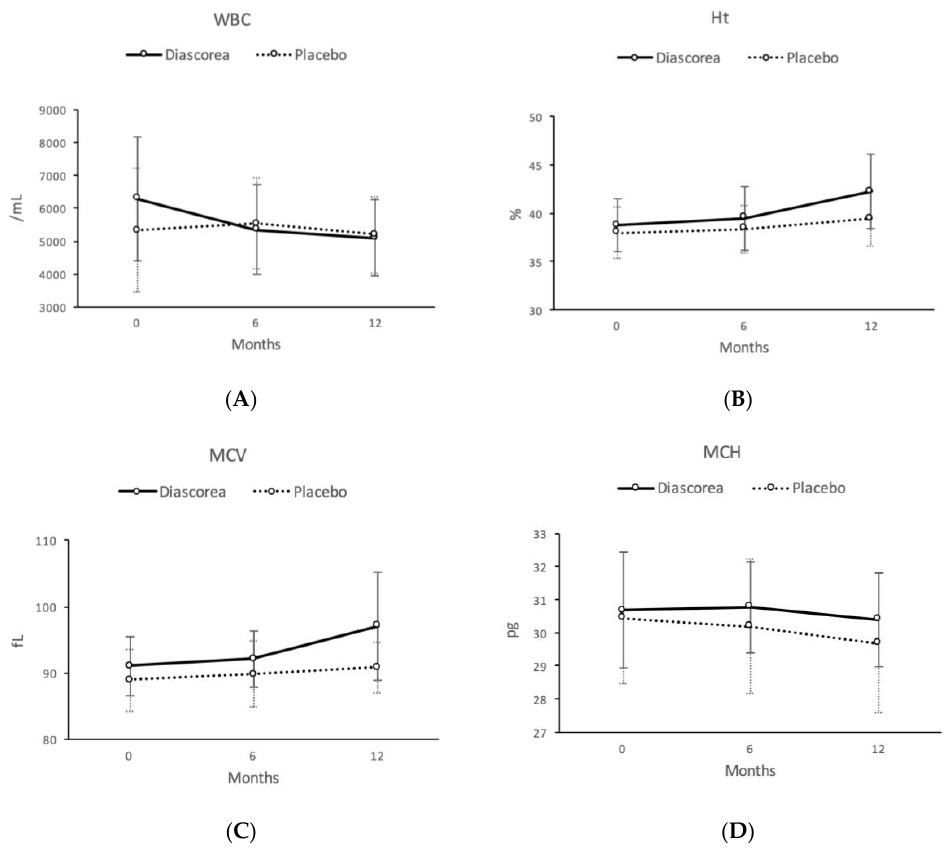
Figure 1. The change patterns of WBC ( A ), Ht ( B ), MCV ( C ), and MCH ( D ) between Month 0, Month 6, and Month